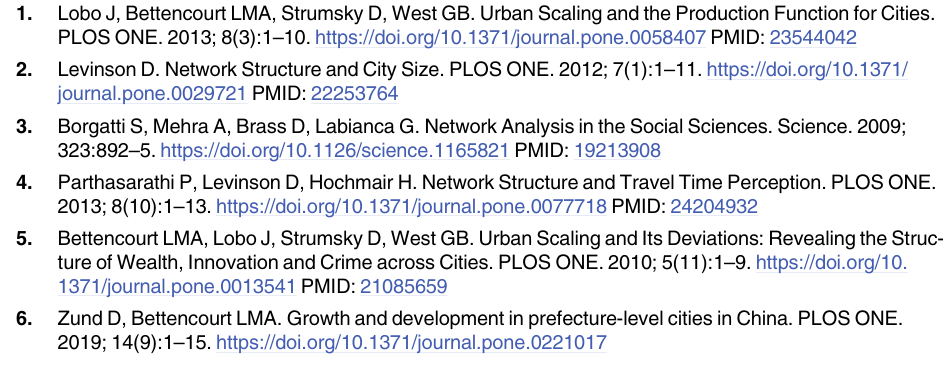
S1 Table. Statistical results of 95 cities. Detailed statistical values of the 95 cities in Shandong